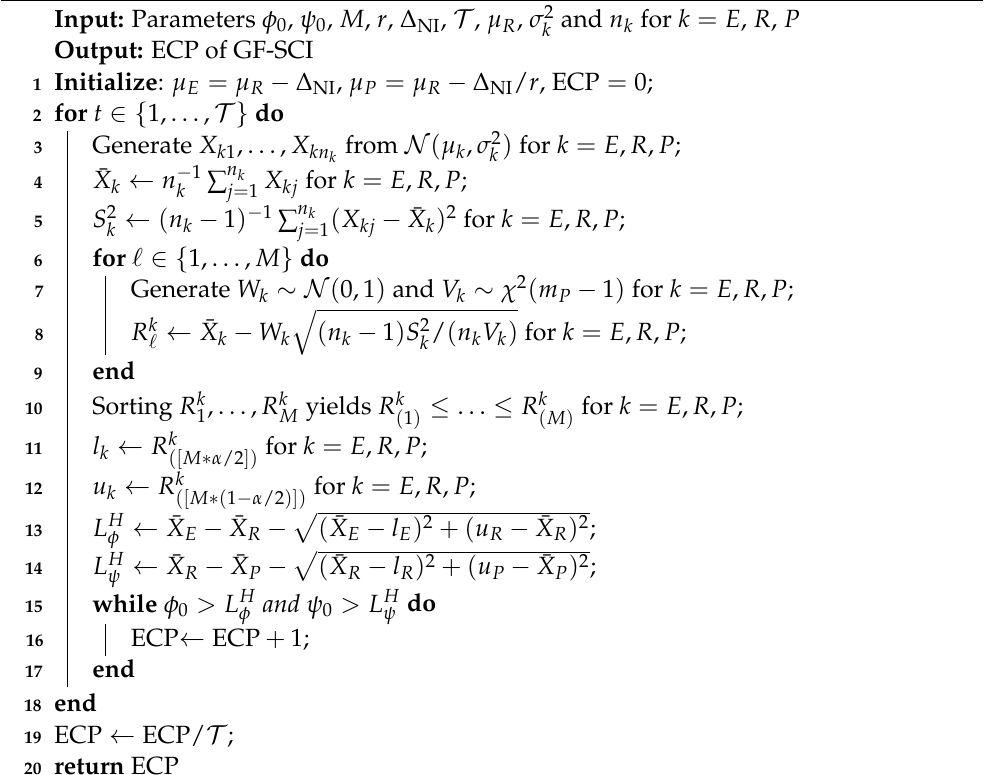
Algorithm 2: Evaluating ECP of